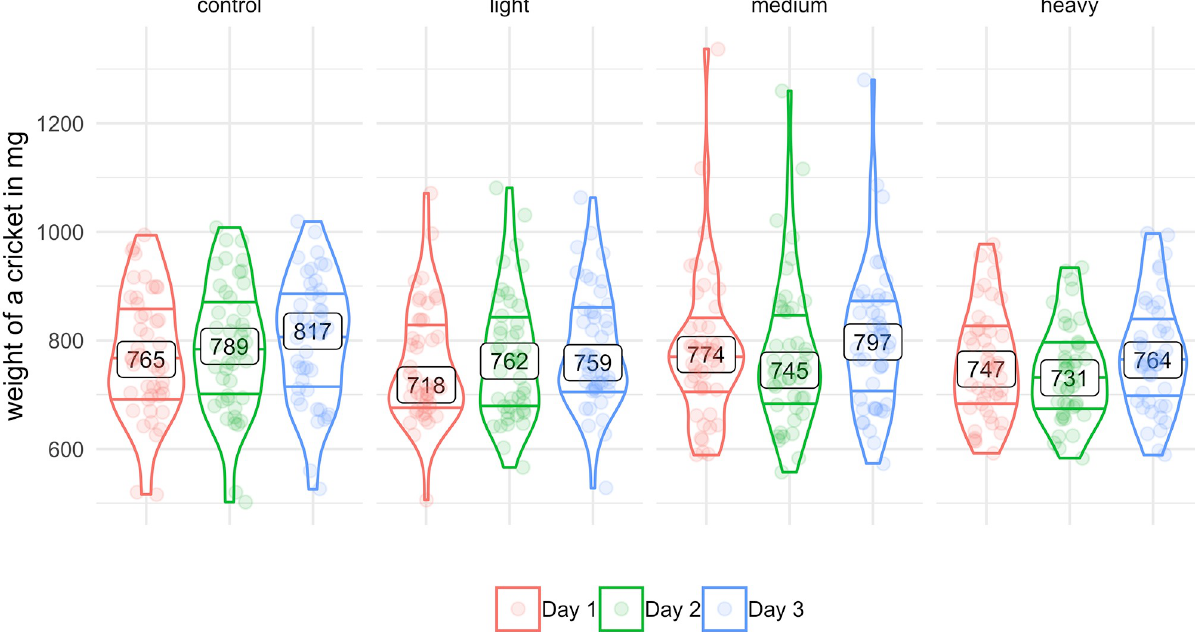
Fig 7. The distributions of cricket weights on all 3 days without regard to temperature. The bottom horizontal lines represent the 1st quartiles, the boxes in the middle indicate the medians, and top horizontal lines represent the 3rd quartiles.